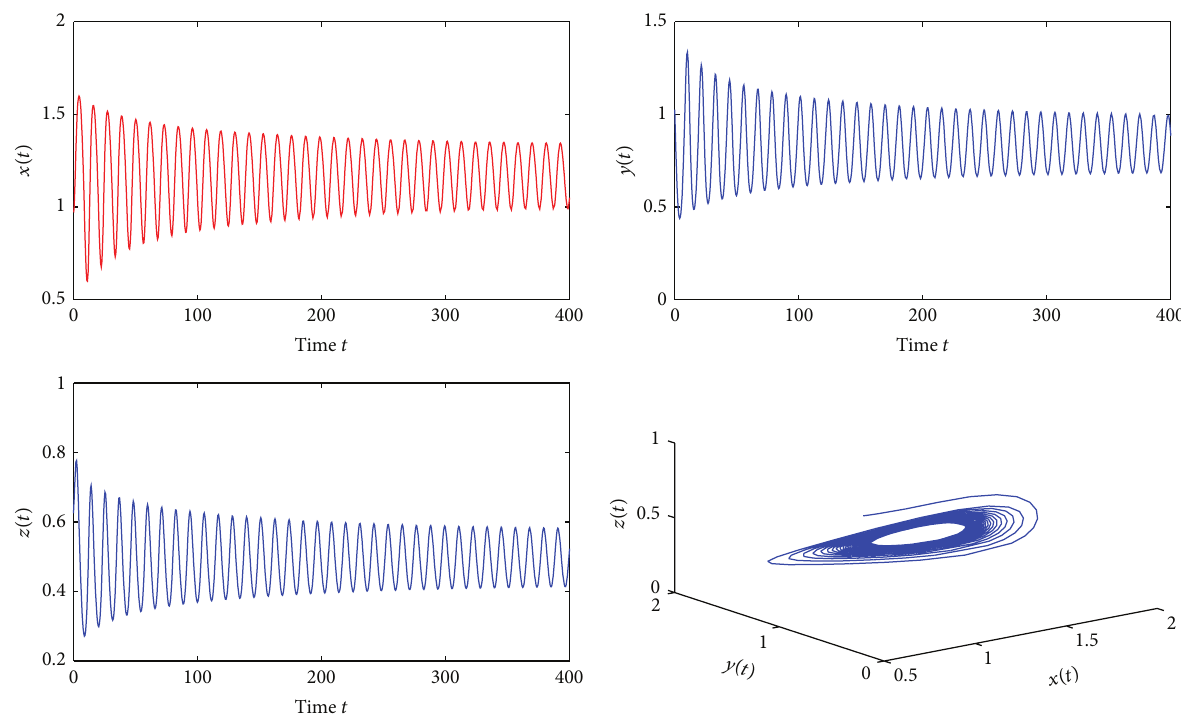
Figure 8: 𝐸 ∗ is unstable for 𝜏 2 = 1.50 > 𝜏 ∗ 2 = 1.4818 and 𝜏 1 = 0.5 with initial values 0.975, 1.025, and